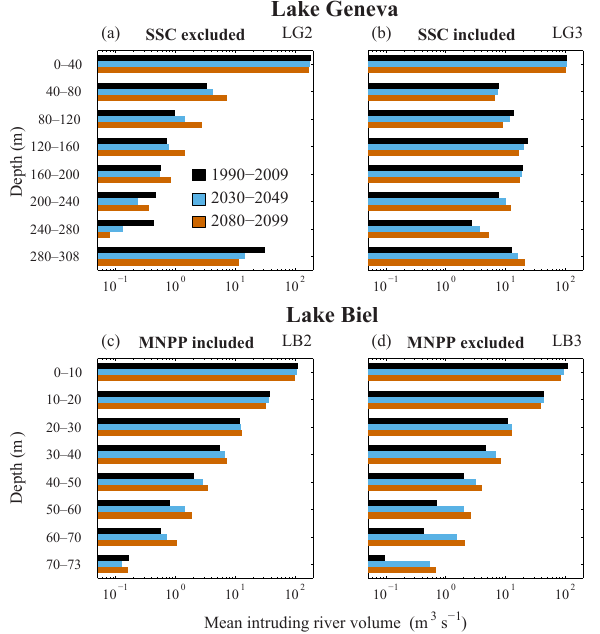
Figure 8. Modeled climate impact on intruding river volumes. Ref- erence (black), near-future (blue) and far-future (orange) time pe- riods for LG (a, b) and LB (c, d) , including (b–d) and exclud- ing (a) river-borne SSC and MNPP heat input included in (c) or excluded (d) from near- and far-future time periods but retained in the reference